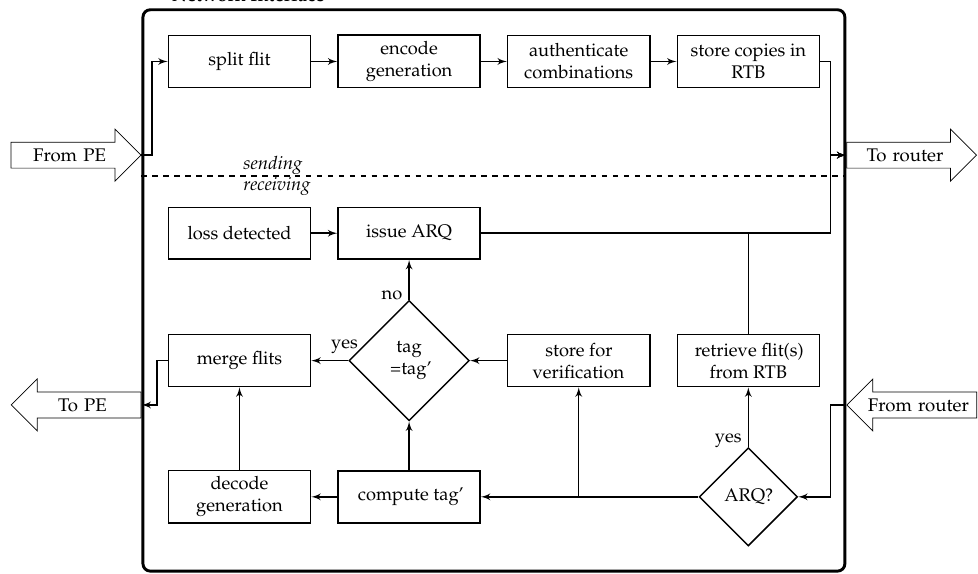
Figure 4. Steps performed by the network interface in case of